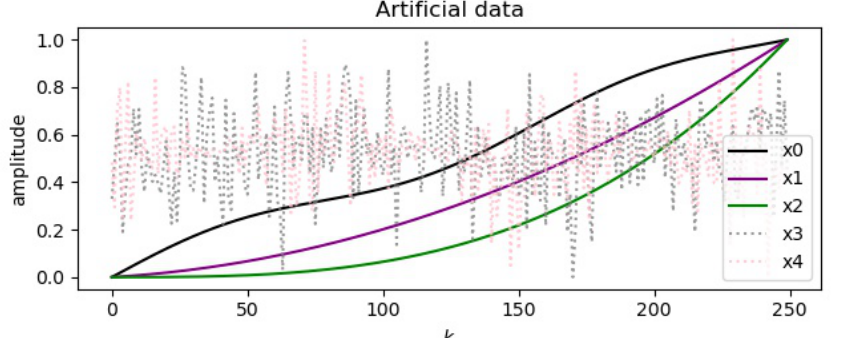
Figure 4. Artificial data for testing, x 0 , x 1 and x 2 together create an output y , x 3 and x 4 are added to the system in order to test the feature selection and wrong feature elimination via BFSA and its validation via MSFNA.